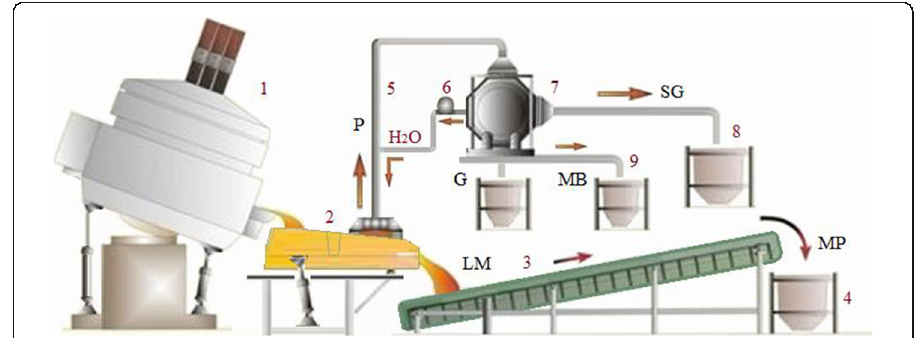
Fig. 11 Simplified schematic diagram of a new technological system for hydro-vacuum granulation of slag melts of ferrous metallurgy (designations — in the